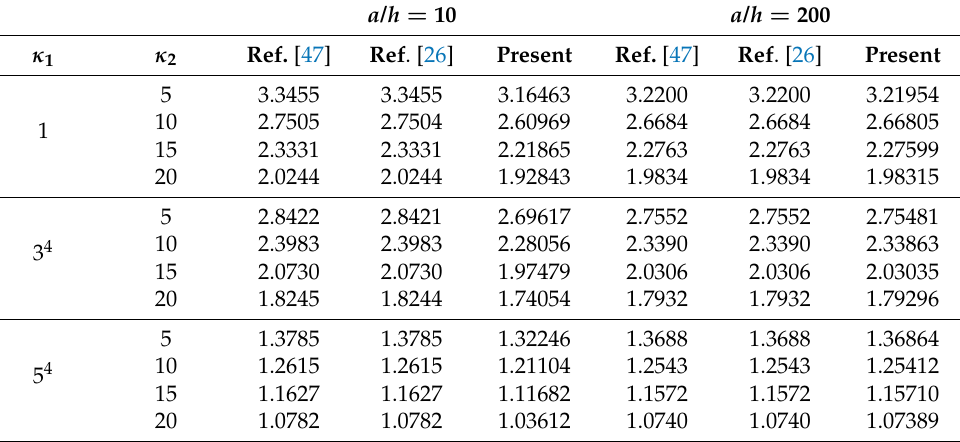
Table 4. Comparison of non-dimensional deflection 10 ¯ w of square plate subjected to uniformly distributed